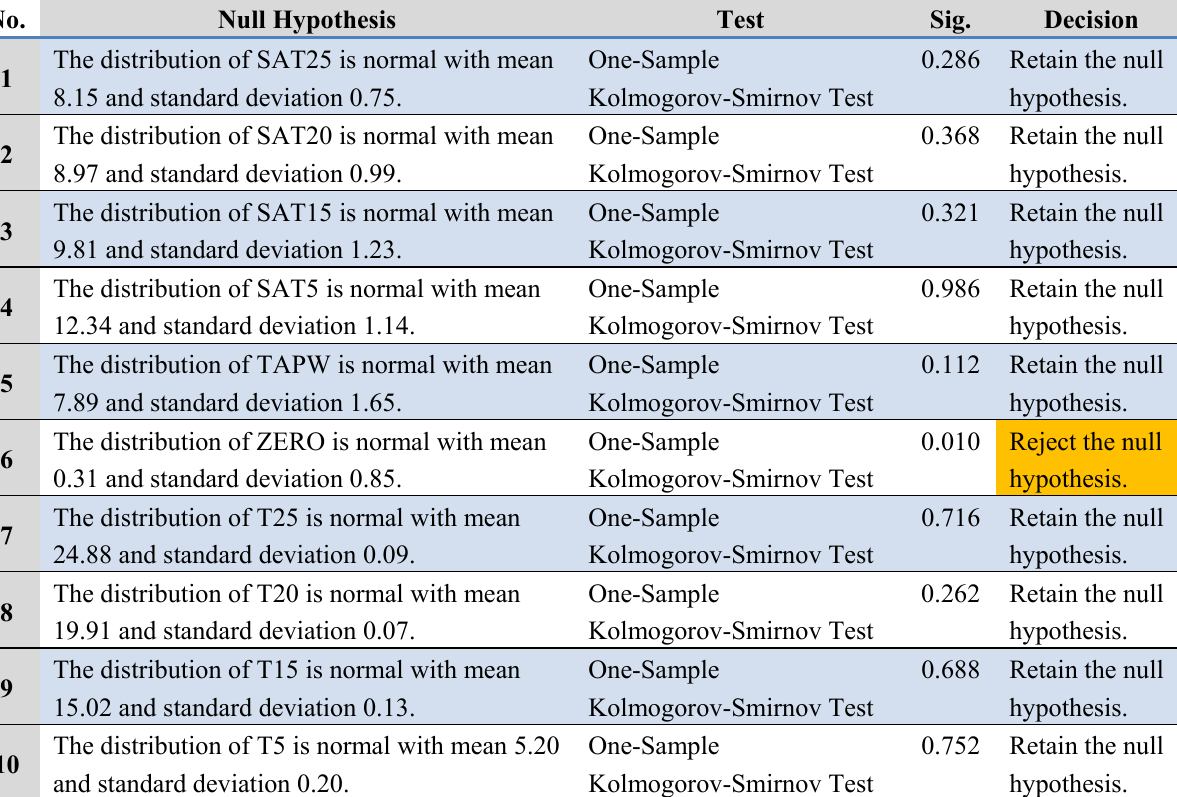
Table 2. Summary of Kolmogorov-Smirnov normality tests for DO and temperature